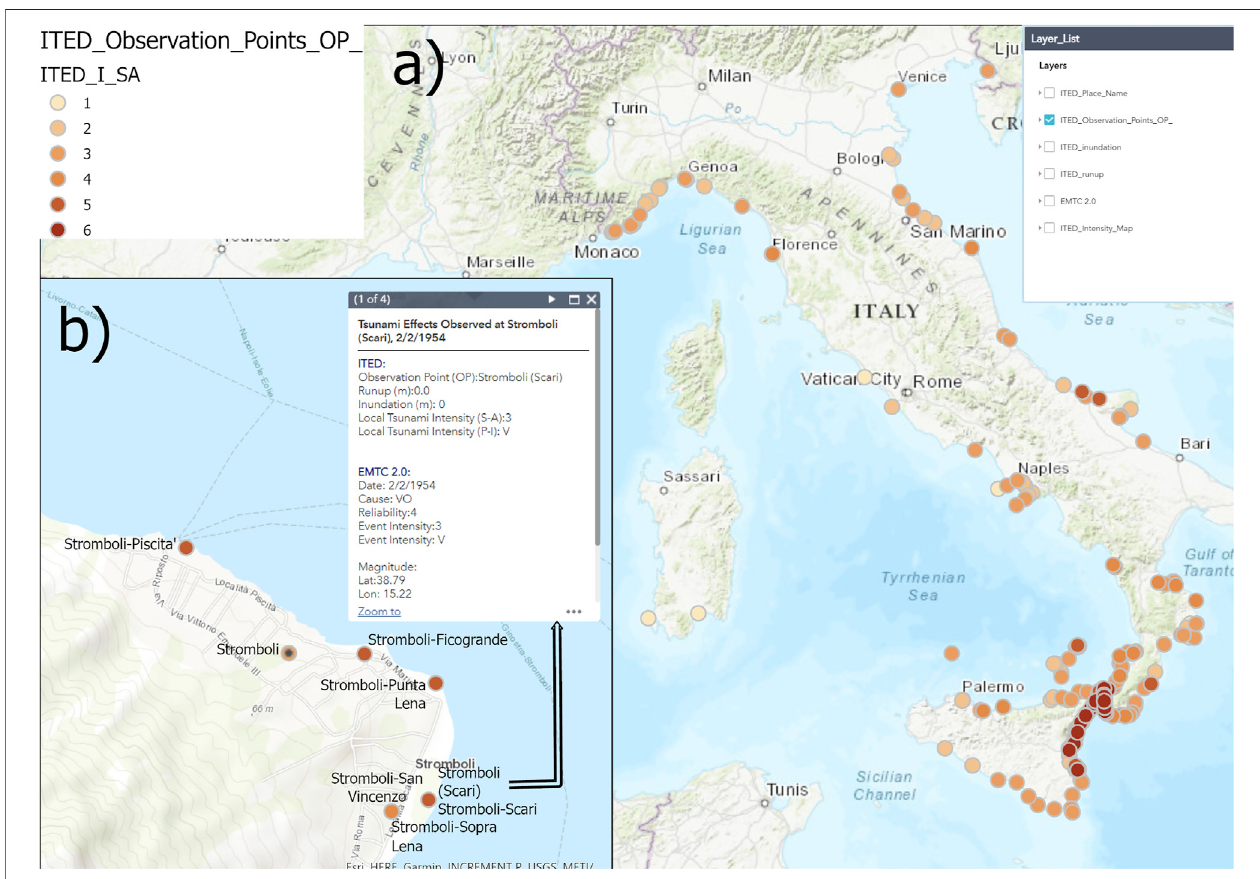
FIGURE1|(A) ScreenshotoftheWebApplayerITED_Obervation_Point.ThecompleteLayerlistisalsoshown. (B) StromboliIsland:theblackdotindicatesthePN (Stromboli-San Vincenzo), whereas the brown dots indicate all the nearby OPs, colored according to local tsunami intensity. By clicking on the OP a pop-up allow the user to get details about the tsunami effects at that point (Service Layer Credits: sources: ©Esri, HERE, Garmin, Intermap, increment P Corp., GEBCO, USGS, FAO, NPS, NOAA, NRCAN, GeoBase, IGN, Kadaster NL, Ordnance Survey, Esri Japan, METI, NASA, Esri China (Hong Kong), ©swisstopo, ©OpenStreetMap contributors 2019. Distributed under a Creative Commons BY-SA